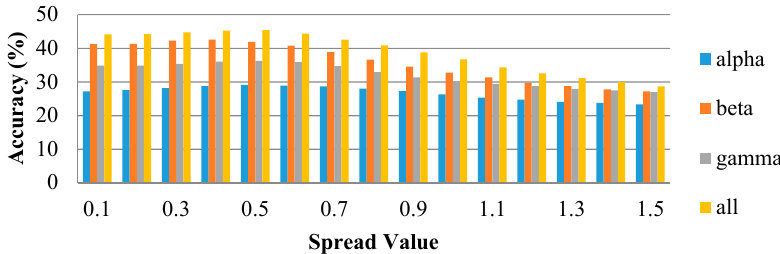
Figure 11. Average classification performance of bispectrum features by varying spread values for the LBD group using probabilistic neural network (PNN).